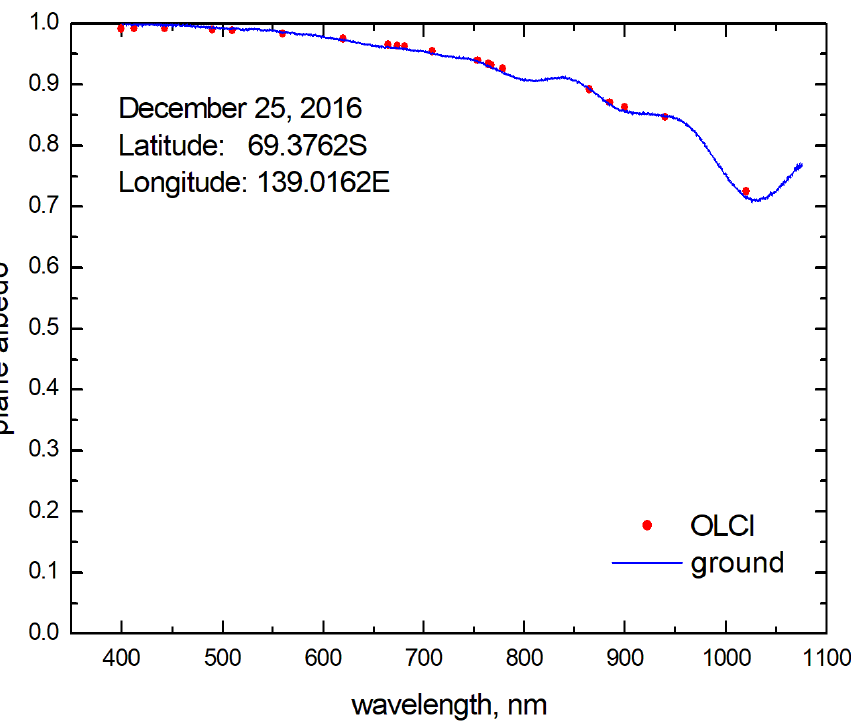
Figure 2. Comparison of the spectral planar albedo, either retrieved by the updated SICE algorithm from Sentinel-3/OLCI measurements (symbols) and observed in situ using the Autosolex instrument (line, data from [33,48] ) at Dome C (Antarctica) on 25 December 2016.